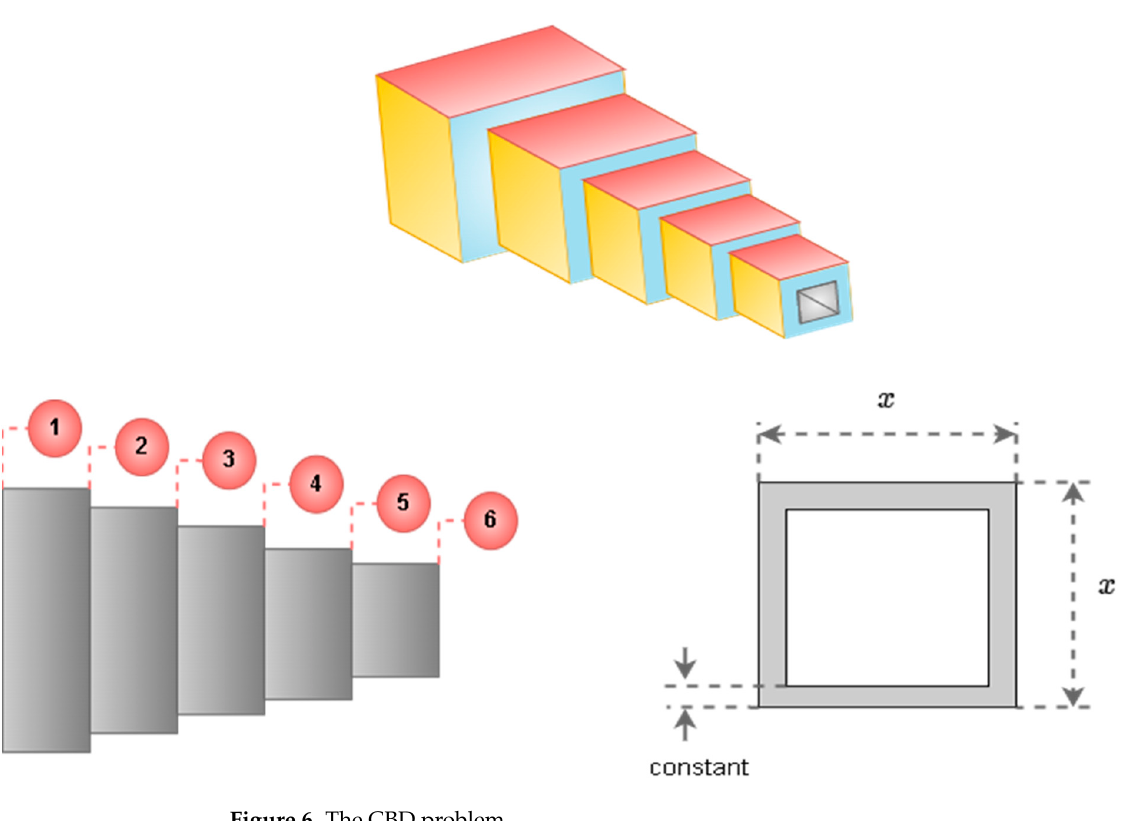
Figure 6. The CBD Figure 6. The CBD problem.